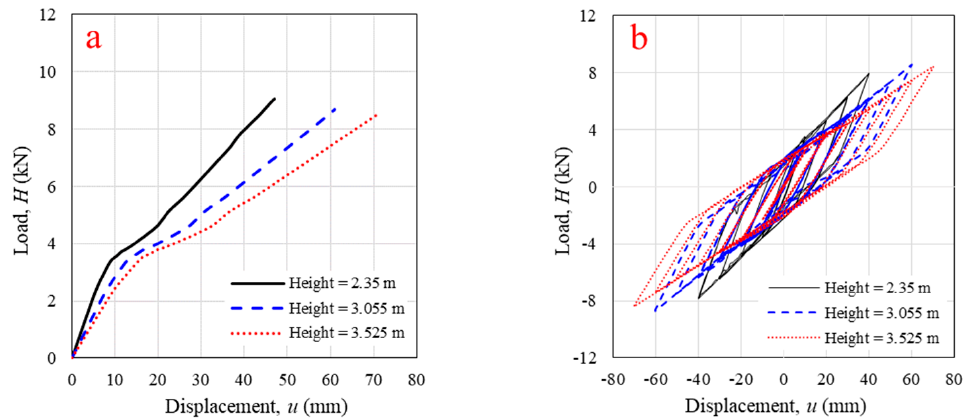
Figure 13. Horizontal in-plane lateral load versus displacement from validated numerical modeling with different log-wall heights under ( a ) monotonic loading; ( b ) cyclic loading.